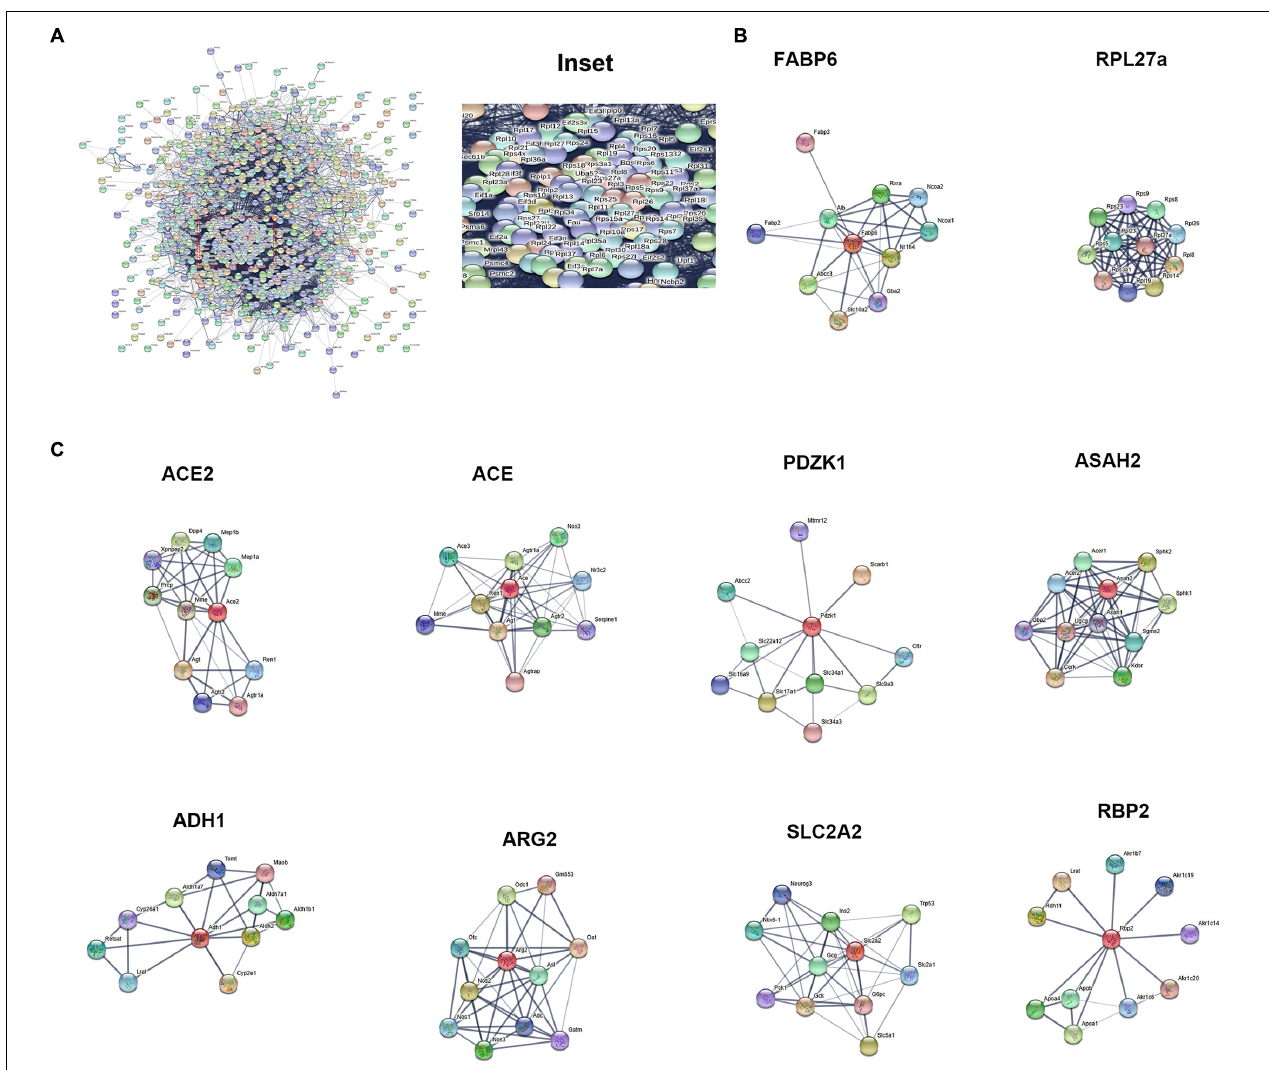
FIGURE 6 | Protein–protein interaction network. (A) PPI network analysis of the hub of the differentially expressed proteins between ileum and jejunum IEC-Exos. (B) PPI network analysis of up-regulated proteins. (C) PPI network analysis of up-regulated